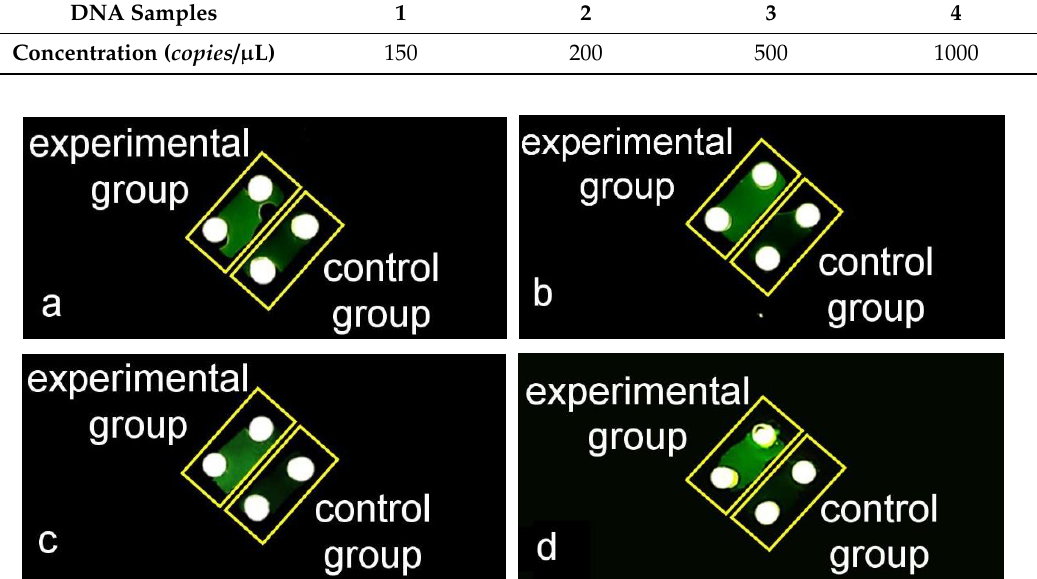
Table 3. Di ff erent initial concentrations of the DNA samples. Table 3. Different initial concentrations of the DNA samples. Table 3. Different initial concentrations of the DNA samples. DNA Samples DNA Samples DNA Samples